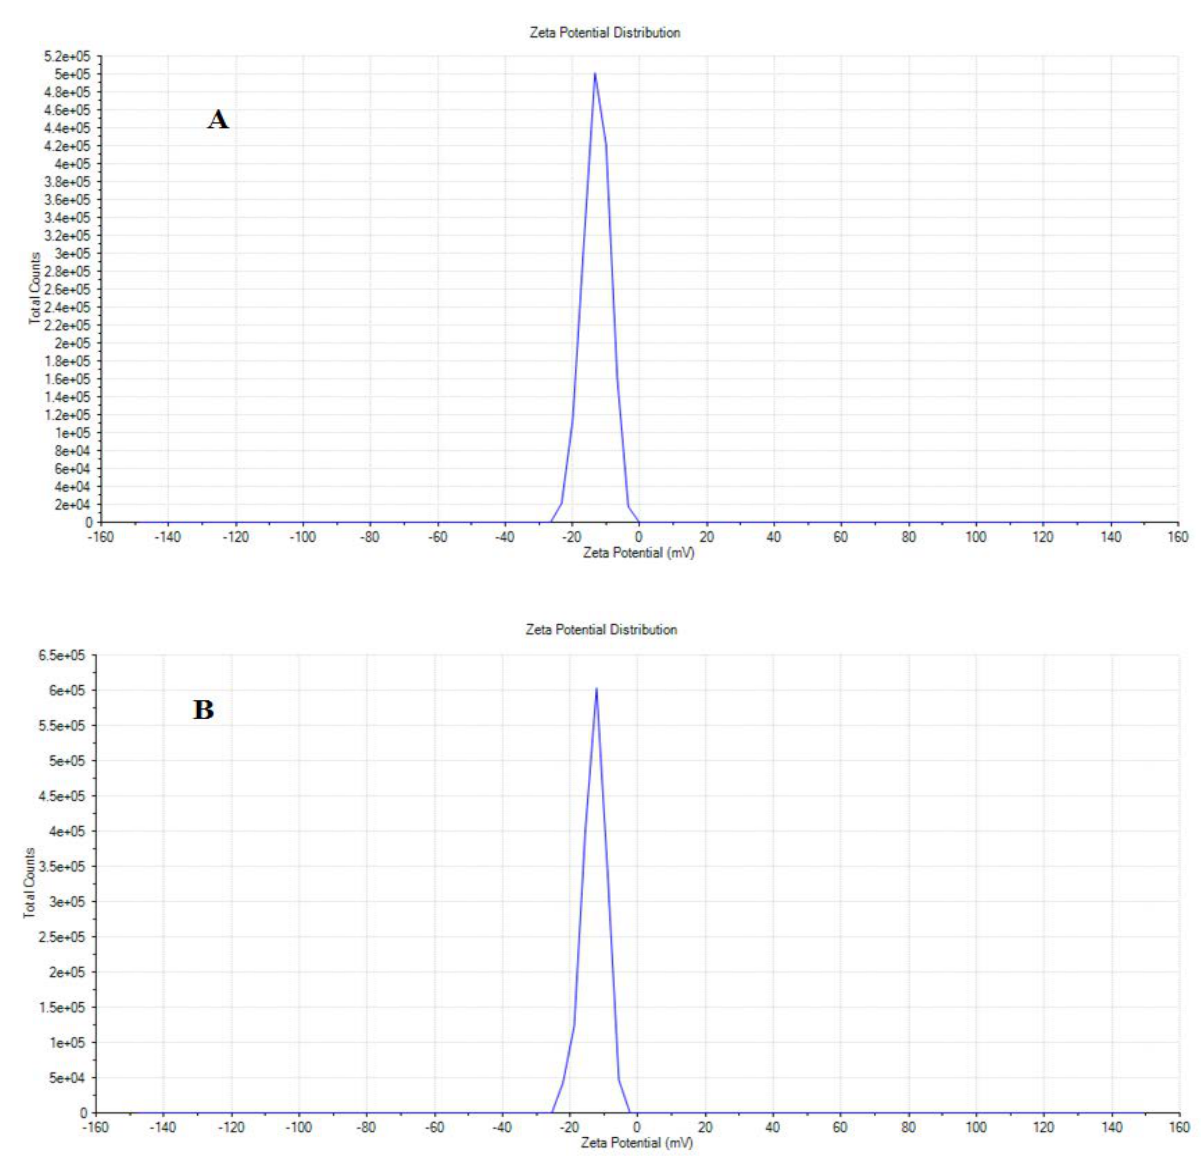
β -Nb 2 ZnO 6 nanoparticles ( A and B